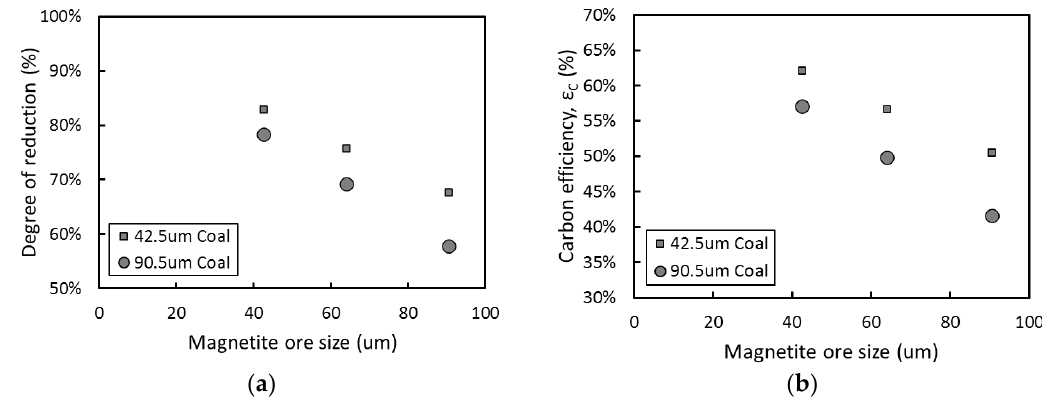
Figure 3. Reduction behaviors with various particle sizes: ( a ) degree of reduction ( b ) carbon efficiency.